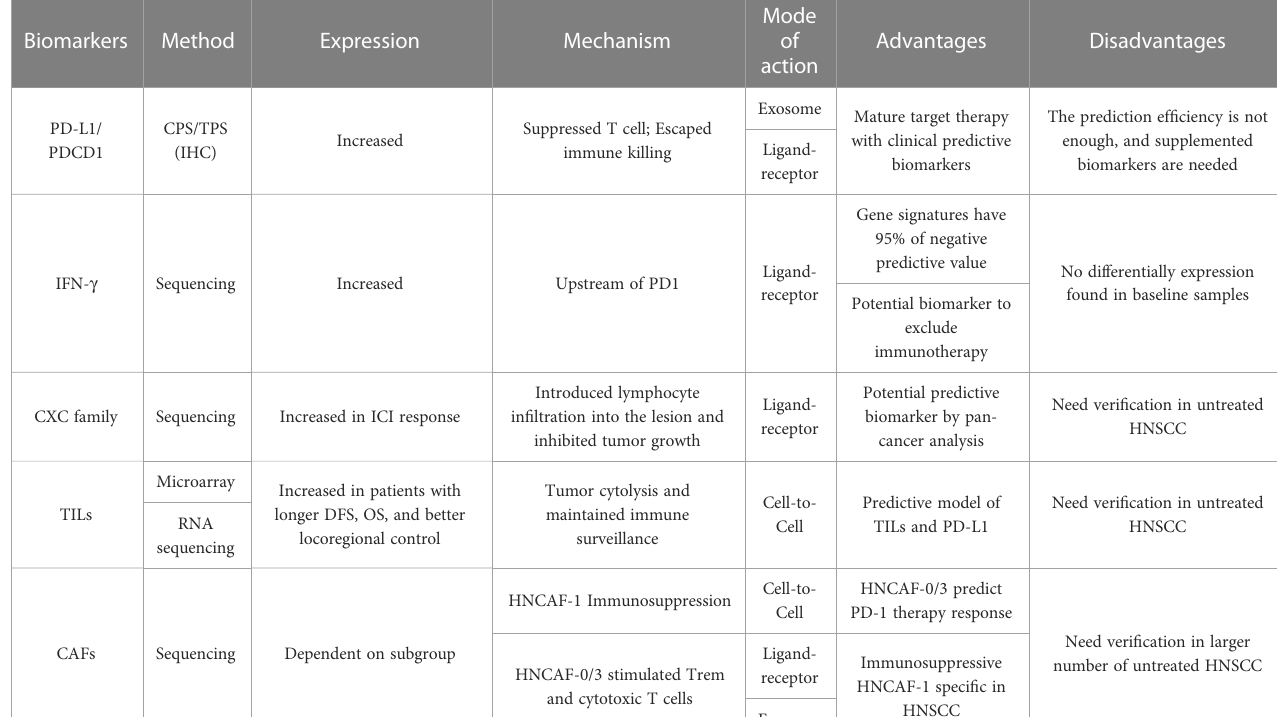
TABLE 1 Biomarkers of immune TME in HNSCC and their advantages and disadvantages.